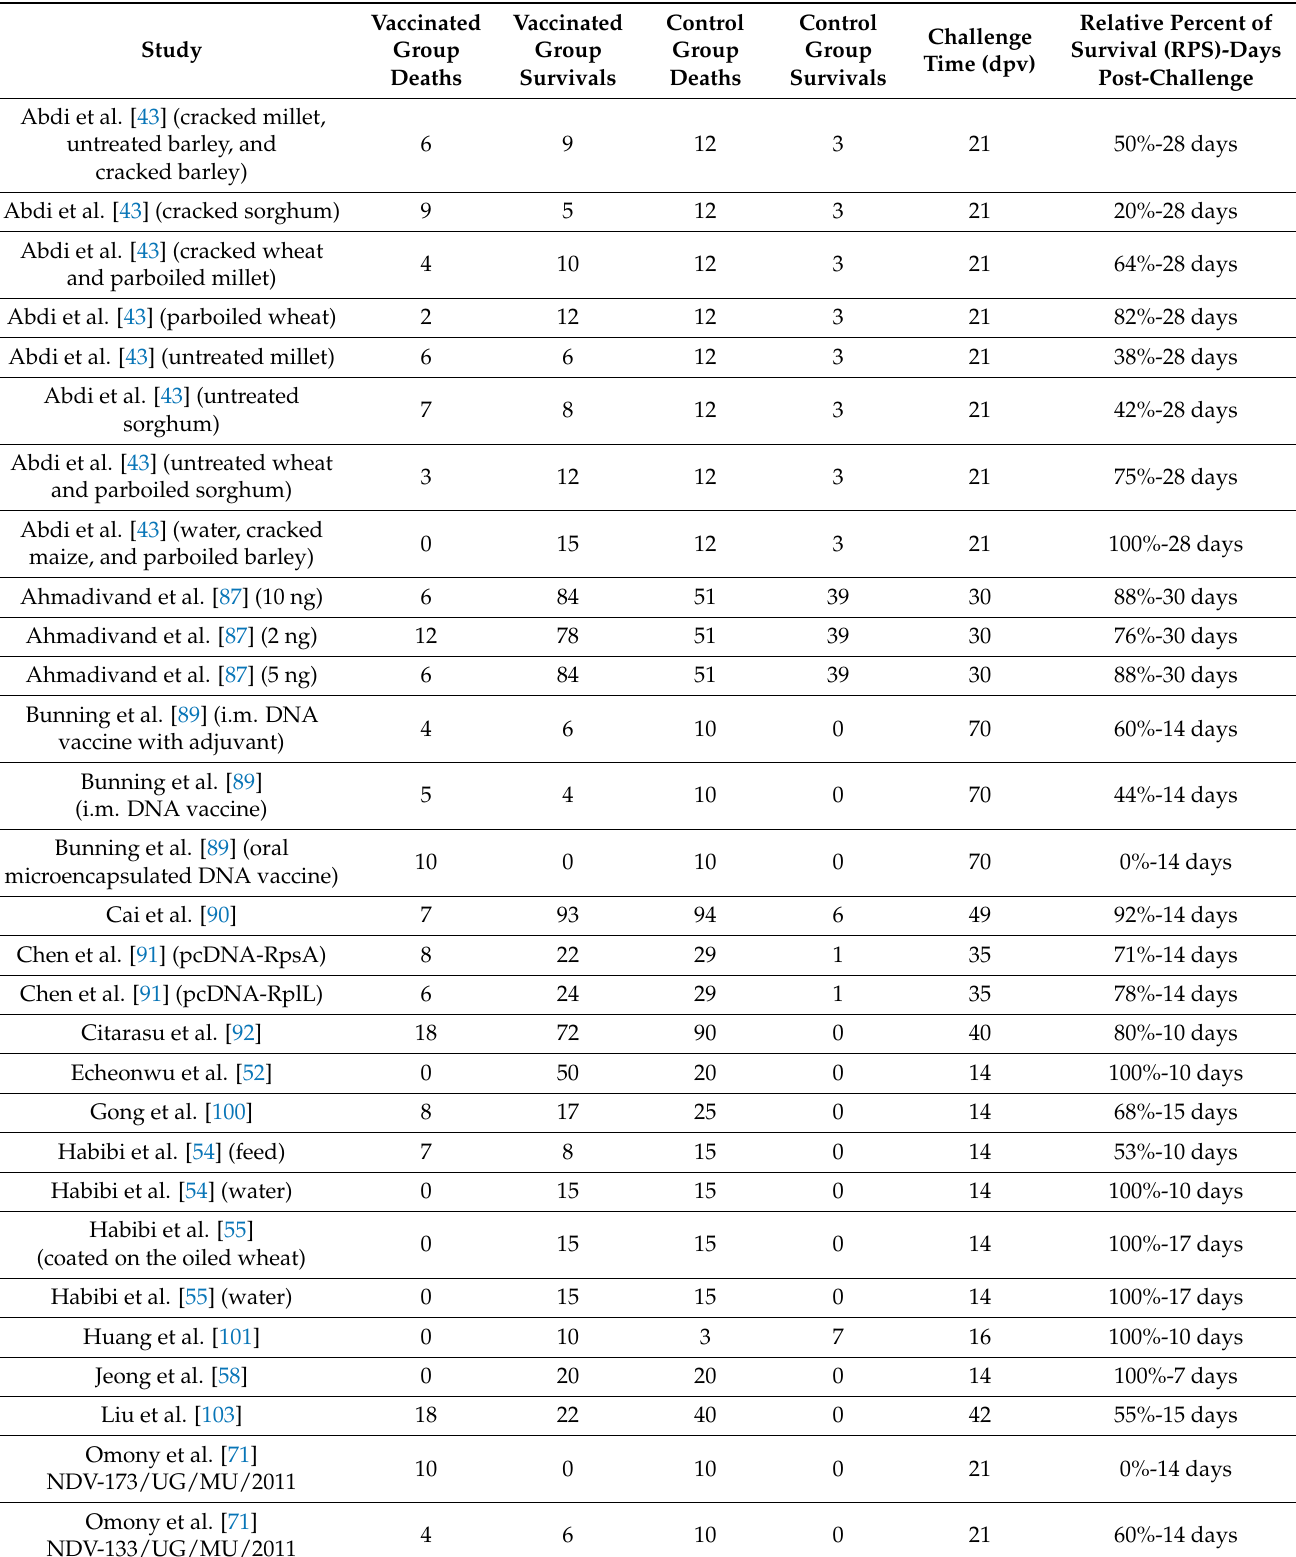
Table 4. Overview of the studies included in the quantitative synthesis to assess the pooled vaccine